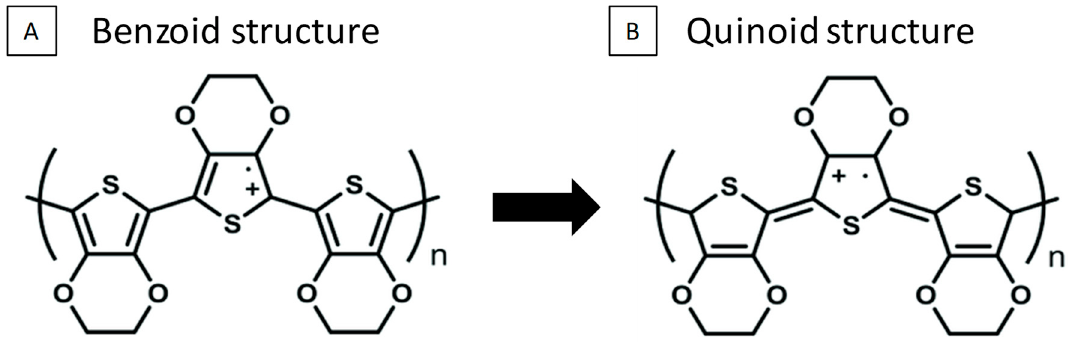
Figure 5. ( A ) benzoid structure and ( B ) quinoid structure. The Seebeck coefficients were positive in all the films measured, showing that PEDOT is a p-type semiconductor (see Figure 4B). This magnitude decreased as the deposition time increased, except for the film grown at 1.4 V for 5 min. The Seebeck coefficients for the films grown at 1.3 V were found to be 31 ± 2, 33 ± 1, and 28 ± 1 µ V/K for 5, 10, and 15 min, respectively. The values of this magnitude for the films deposited at 1.4 V were 27 ± 2, 21 ± 2, and 13 ± 4 µ V/K for 5, 10, and 15 min, respectively. Finally, the Seebeck coefficient was higher for films deposited at 1.3 volts, with the highest value discovered in films deposited for 10 min. The Seebeck coefficients found in the literature for films grown under similar conditions (acetonitrile, lithium perchlorate, and electropolymerization) were 9 µ V/K [11] and 18.9 µ V/K [12]. The PEDOT film grown in this work with the highest Seebeck coefficient exhibits a value 1.8 times higher than the highest